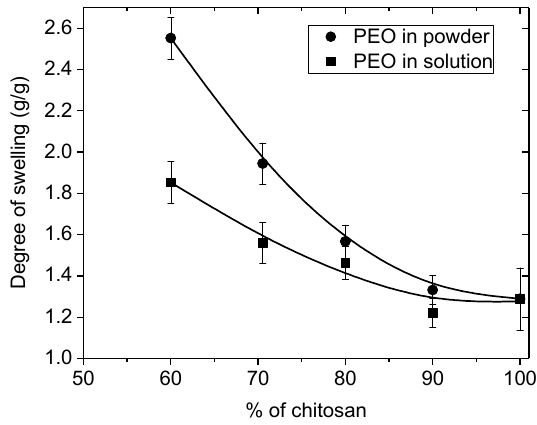
Figure 2. Influence of the initial PEO content in rehydration of chitosan films as a function of w / w % of chitosan in the blend ( ● powder form; ■ solution 5%, M W = 1 × 10 6 ).